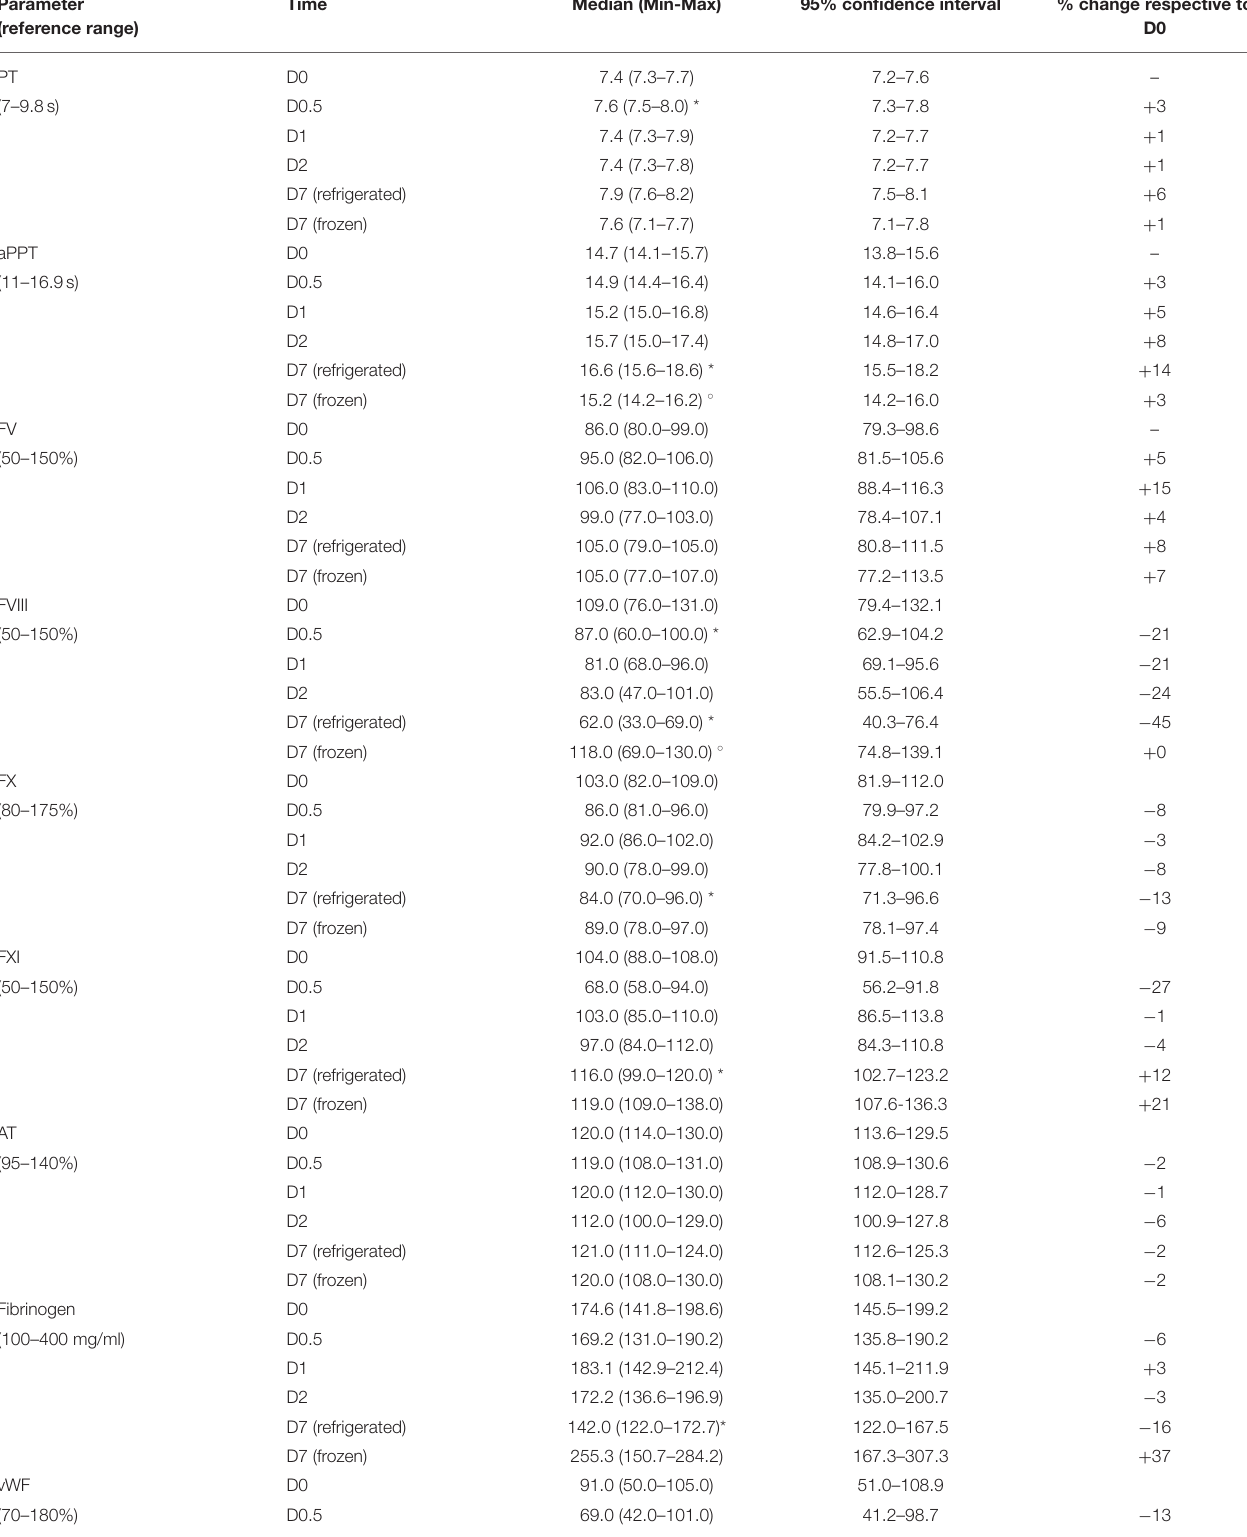
TABLE 1 | Descriptive statistics for hemostatic activity in five paired canine plasma units stored as never-frozen liquid plasma and fresh-frozen plasma evaluated at collection (baseline value, D0), after 12 (D0.5), 24 (D1), and 48h (D2) of refrigerated storage, and after 7 days stored refrigerated (D7 refrigerated) or frozen (D7 frozen). Parameter (reference